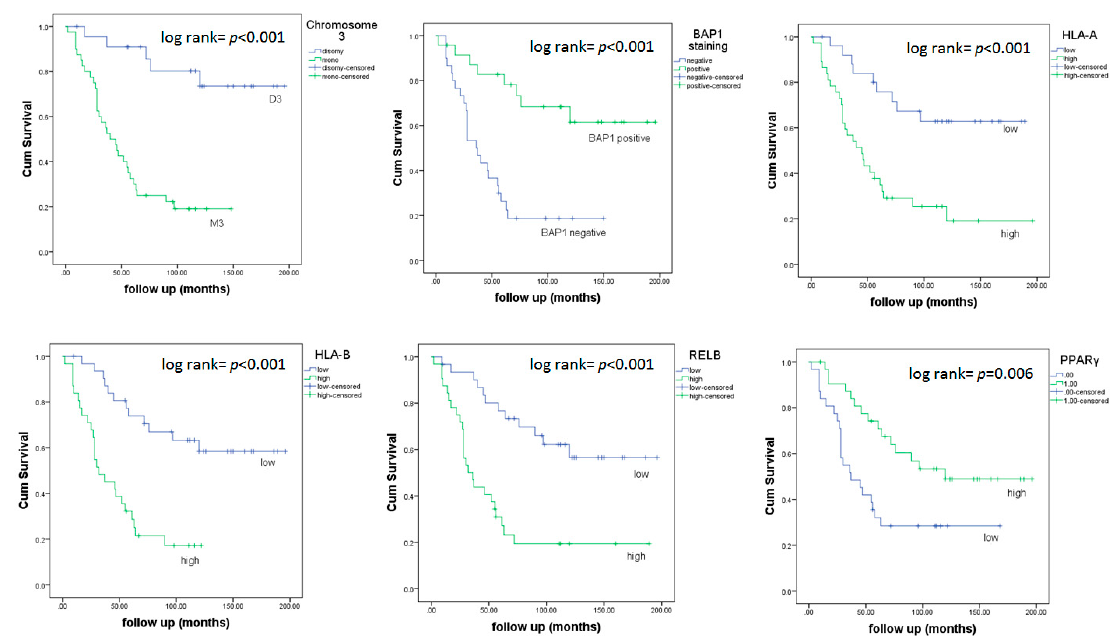
Figure 2. Kaplan–Meier survival curves based on chromosome 3 status, BAP1 staining and mRNA expression of HLA-A, HLA-B, RELB and PPAR γ . A log-rank test was used for the significance analysis.